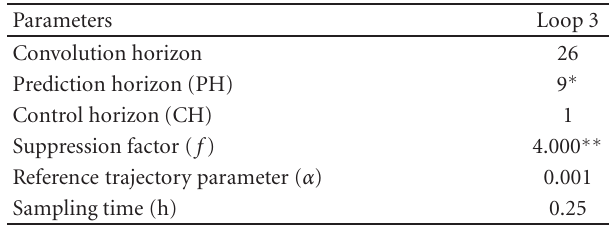
Table 6: Sensitivity analysis parameters of DMC for servo problem. Parameters